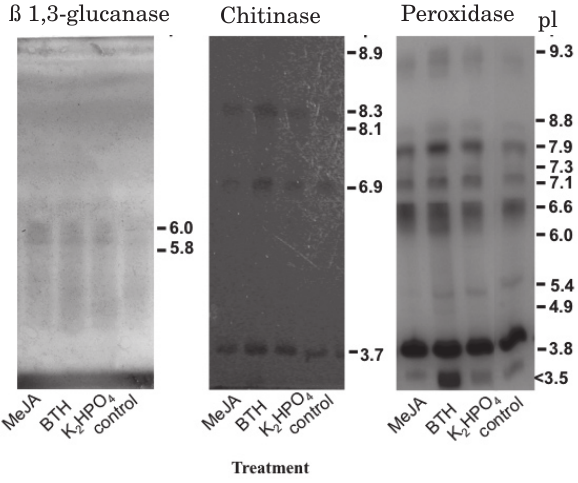
Fig. 6. β 1,3-glucanase, chitinase and peroxidase isoen- zyme patterns in melon rootlets raised from seed treat- ed with methyl jasmonate (MeJA), acybenzolar-S-me- thyl (BTH), dipotassium hydrogenphosphate (K and water (control) 48h after seed germination. Equal amount of total protein (10 µg) per lane was applied. Estimated pI values are indicated on the